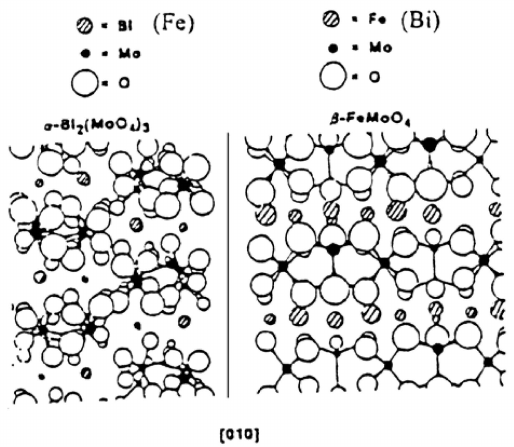
Figure 13. Epitaxial match of (010) face of Bi 2 Mo 3 O 12 and β -FeMoO 4 . (From [77] copyright 2016, Elsevier